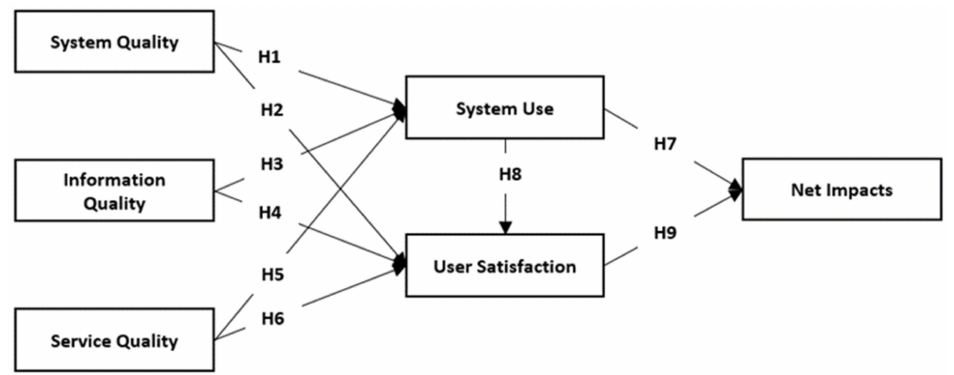
Figure 1. Research model.